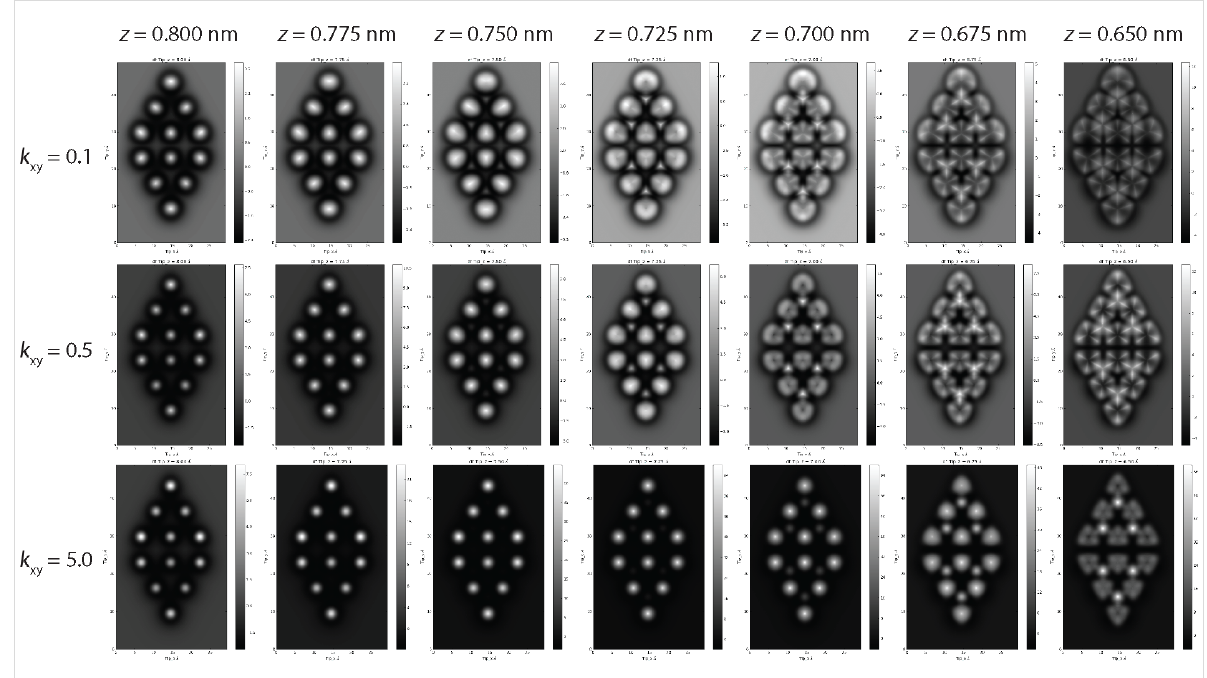
Figure 4: Simulated constant height images at decreasing tip–sample separation for three different probe lateral stiffness ( k xy ). The triangular appear- ance of the adatoms, and the subsequent contrast inversion, occurs at larger tip separations for lower stiffness probes. For the lowest stiffness probe the ‘hole’ produced by the contrast inversion is almost reduced to a point due the the extreme sharpening of the features caused by the deflection of the